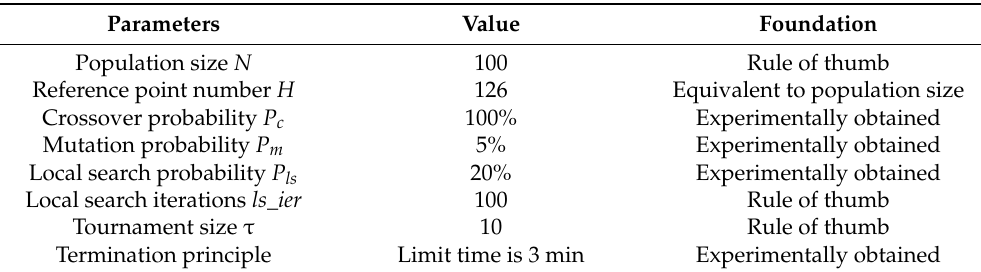
Table 5. Parameter setting for